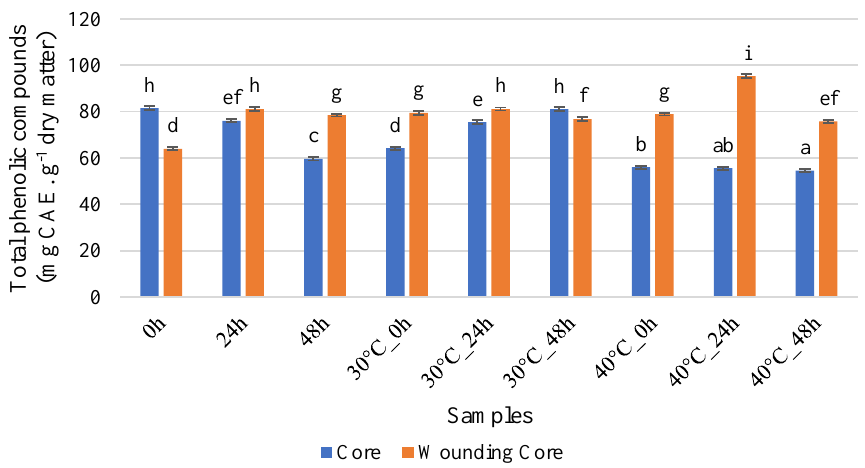
Figure 3. Effect of abiotic stresses, heat treatment and wounding, on total phenolic content of pineapple core. Error bars stand for ± standard deviation ( n = 9). Different letters express significant differences between samples.